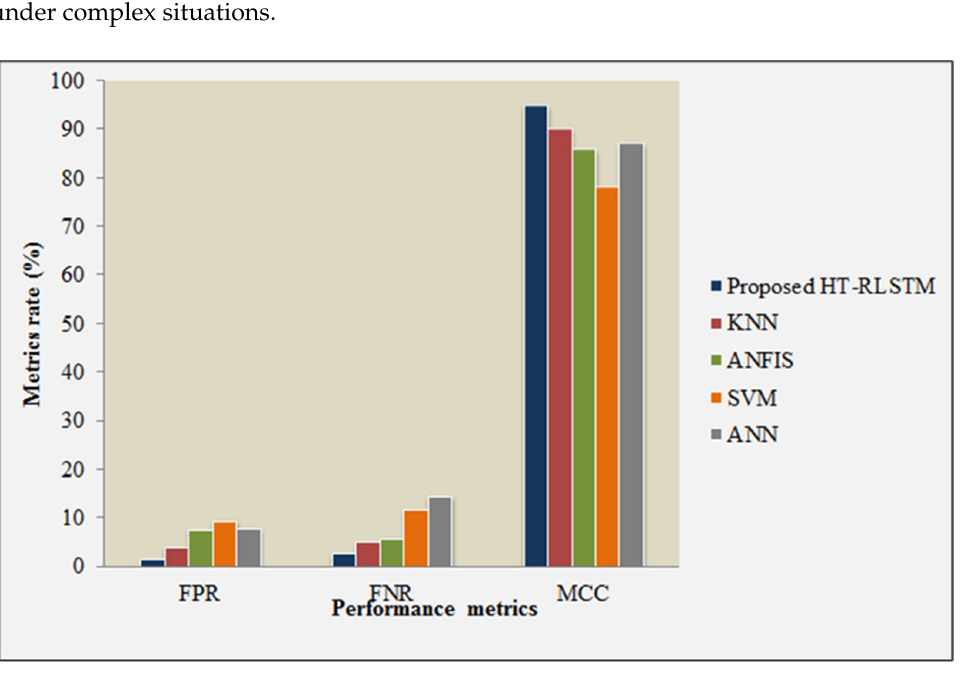
Figure 5. Comparative analysis of proposed HT-RLSTM with respect to FPR, FNR, and MCC.